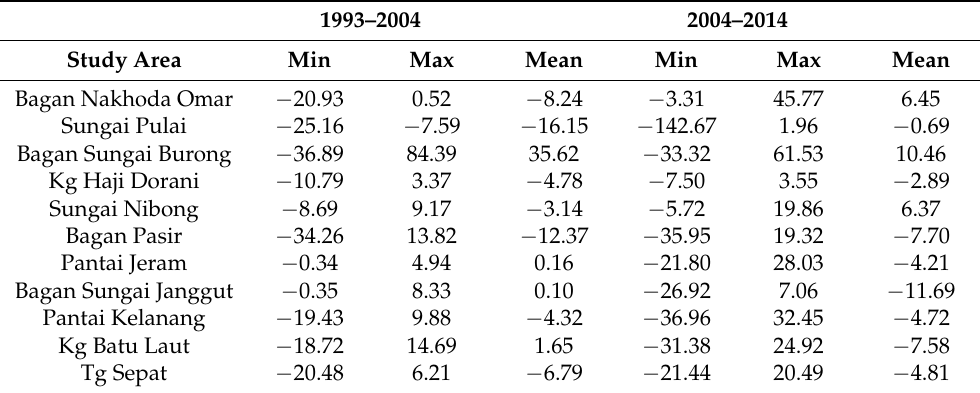
Table 5. Rate of shoreline changes using the endpoint rate (EPR)